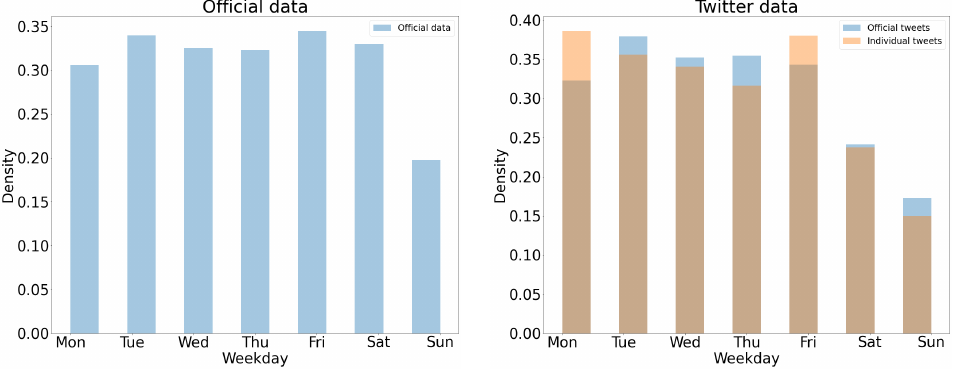
Figure 7. Distribution of reported accidents on Twitter and Official Register by day of the